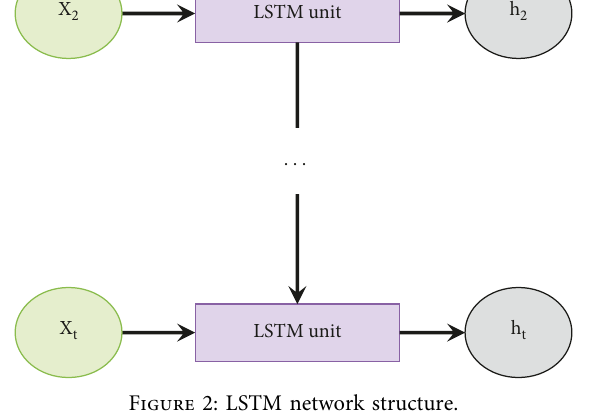
Figure 2: LSTM network structure.